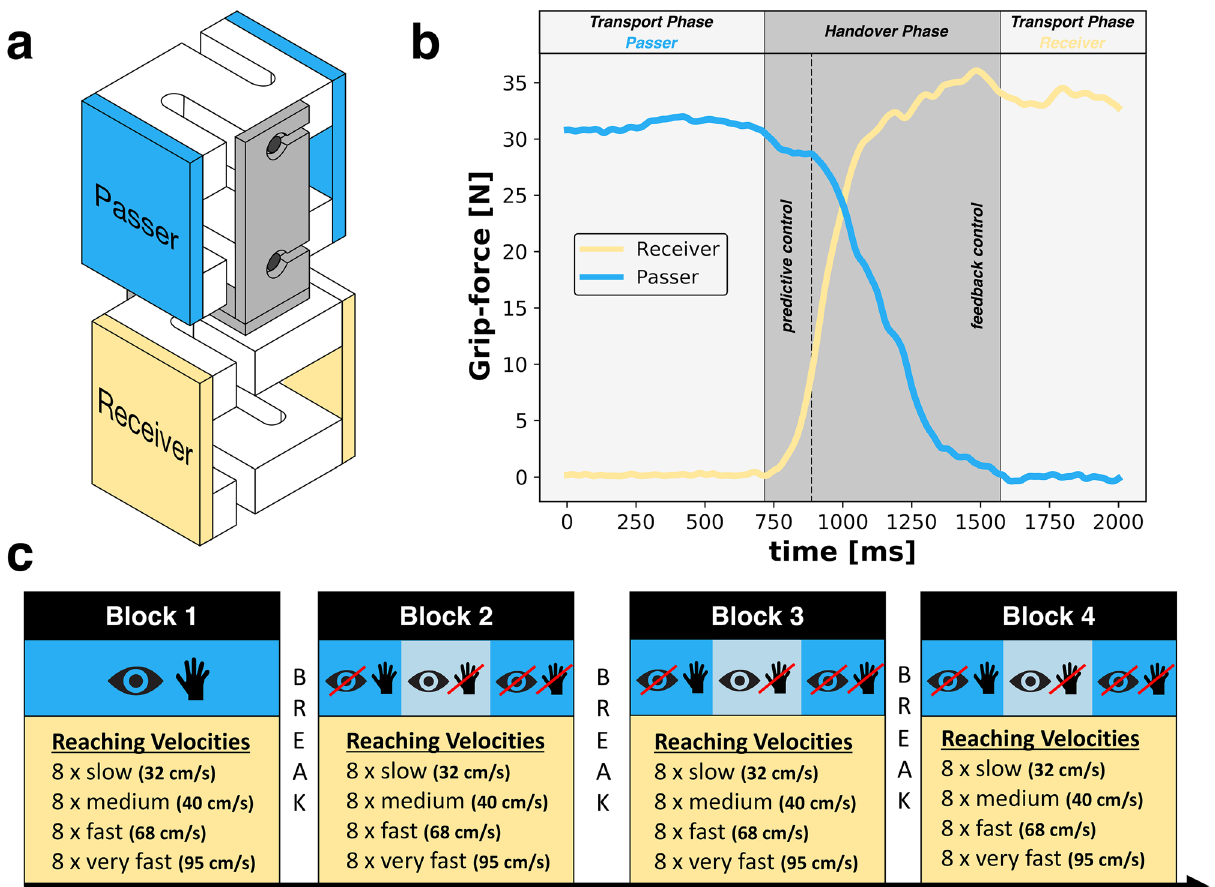
Figure 5. ( a ) Graphical illustration of the measuring device used to record the grip-forces of passer (blue) and (orange) receiver. Each side was constructed of two strain-gauge-sensors connected to a metal frame (grey). ( b ) Exemplary course of grip-forces of passer and receiver during one handover. ( c ) Schematic depiction of the study design. Each block consisted of 32 handovers with a 2-min break in between the blocks. Sensory information was manipulated on the passers side (shaded in blue) and reaching velocities were varied for the receiver (shaded in orange). In blocks 2–4, conditions were conducted counter